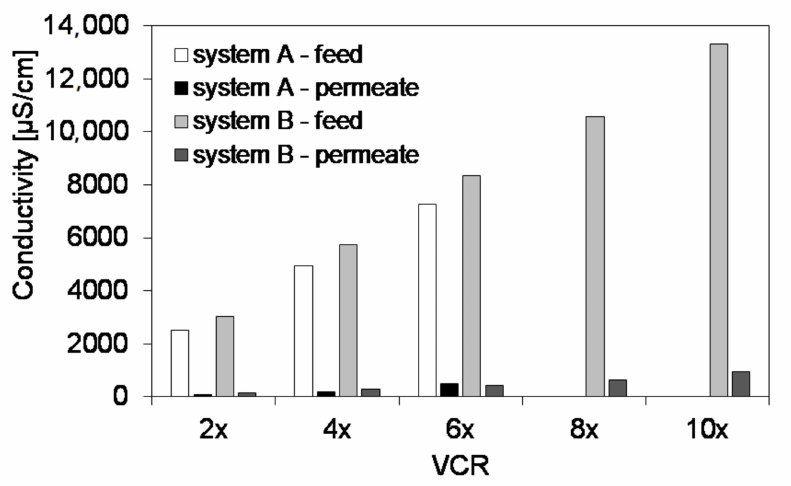
Figure 8. Comparison of conductivity of feed and permeate for various VCR in systems A and